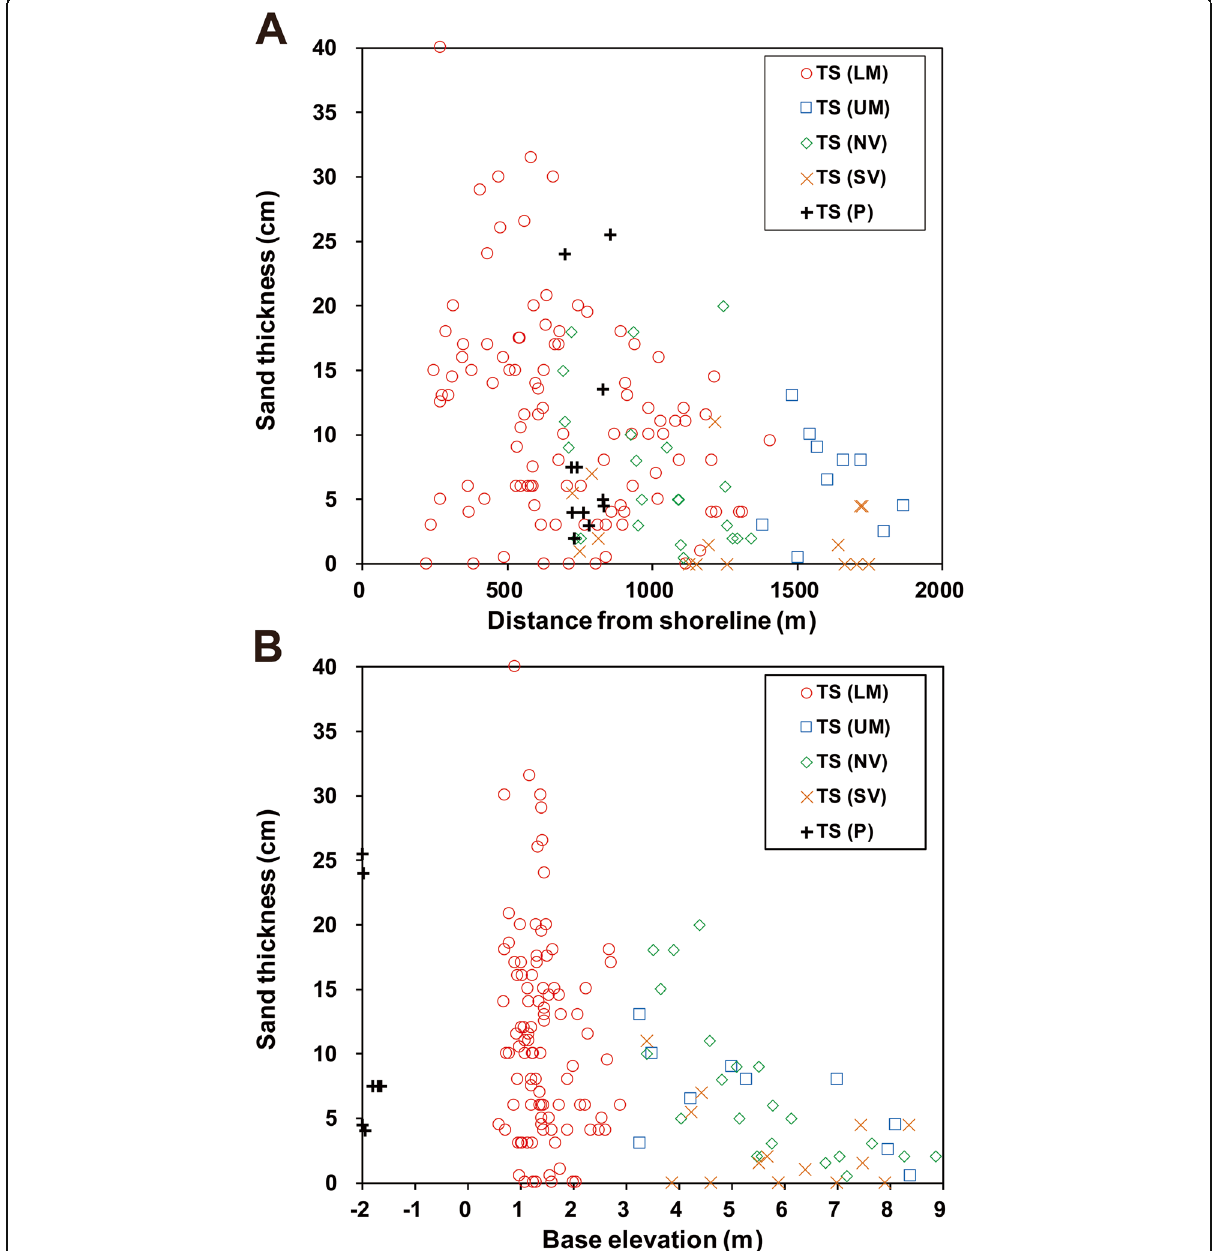
Fig. 4 Thicknesses of tsunami sand shown by each topographic type against the inland distance from the shoreline ( a ) and the base elevation ( b ). Control point of measurement of the distance from the shoreline is shown in Fig. 1b. Base elevation means the elevation (above T.P.) of the bottom of tsunami deposit. TS, tsunami sand layer; LM, lower main valley; UM, upper main valley; NV, north sub-valley; SV, south sub-valley; P,